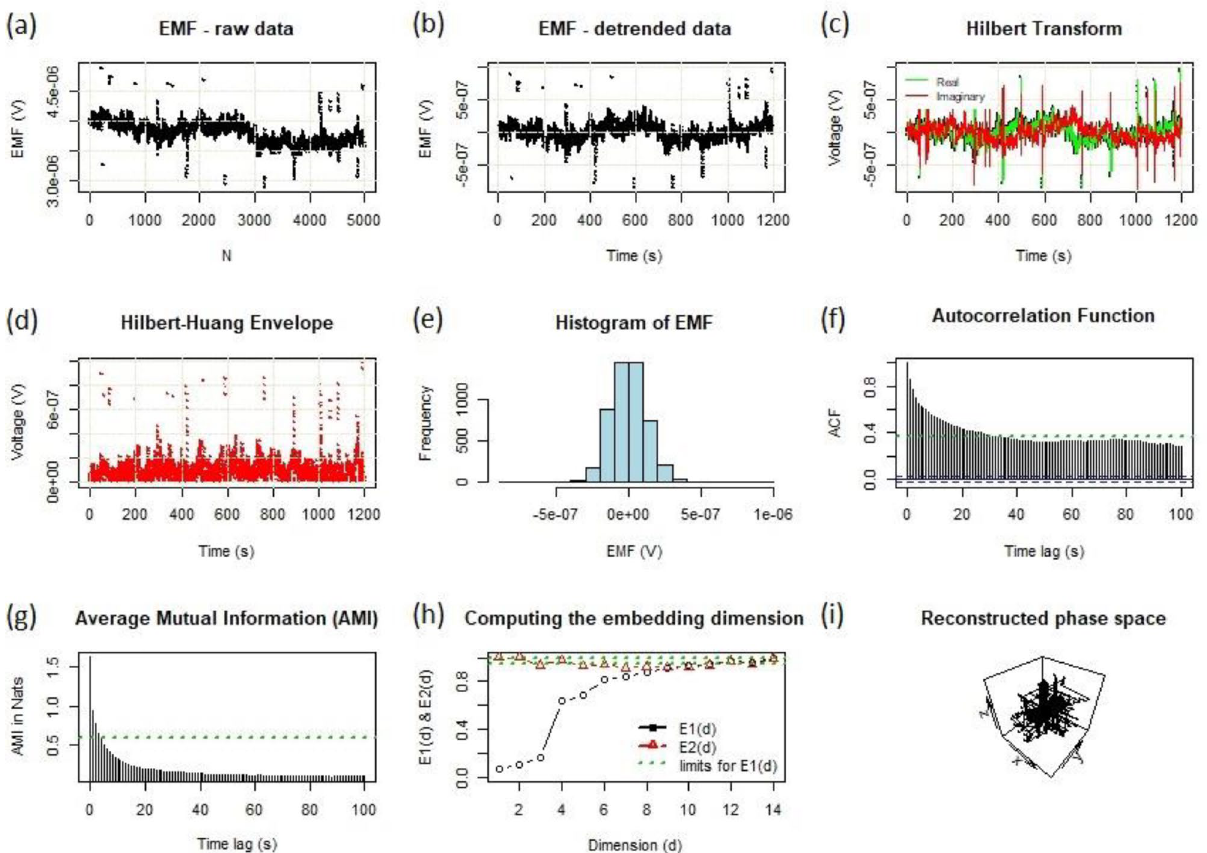
Figure 5. Different complexity measures of a collection of hyacinth pollen tubes at temperatures different from the optimum growth temperature ( T = T c ) close to 20.2 °C. ( a ) Electromotive force (EMF) as a function of the point counter ( N ). [EMF can be measured as an open circuit potential difference or voltage that can drive an electric current if an external circuit is connected to the terminals]. ( b ) Detrended data from ( a ). ( c ) Hilbert transform. ( d ) Hilbert–Huang envelope. ( e ) Histogram of EMF. ( f ) Autocorrelation function and ( g ) Average mutual information as a function of the time delay. ( h ) Computing the embedding dimensions. ( i ) Reconstructed phase space trajectory according to Takens’ theorem. Representative chart from 62 measurement